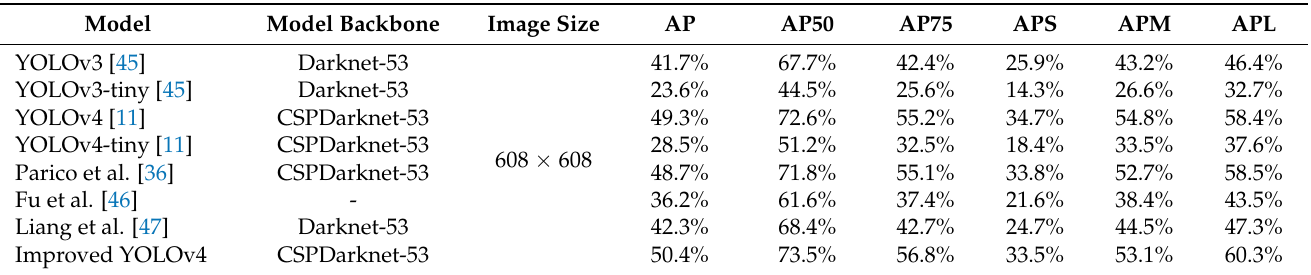
Table 7. Comparison of fruit and vegetable classification models average precision with the augmented